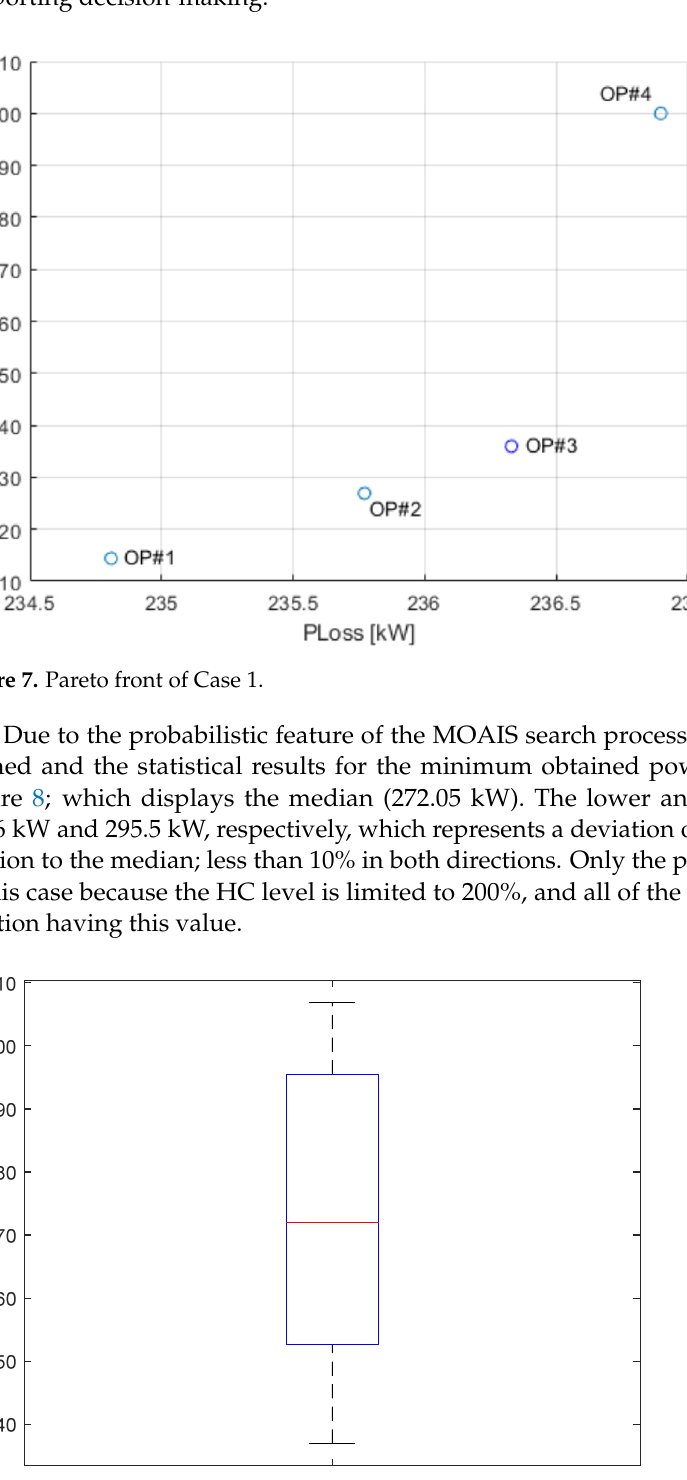
14 of 24 Table 5. Nondominated solutions from MOAIS, Case 1. Power